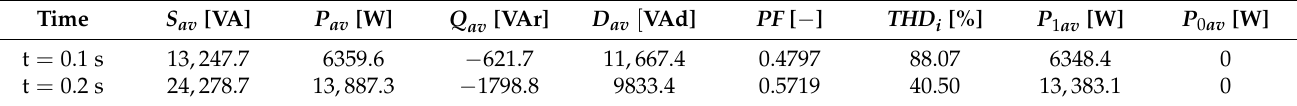
21. 21. Table 21. Simulation results before and after the change (at steady states). Table 21. Simulation results before and after the change (at steady states). Table 21. Simulation results before and after the change (at steady states).